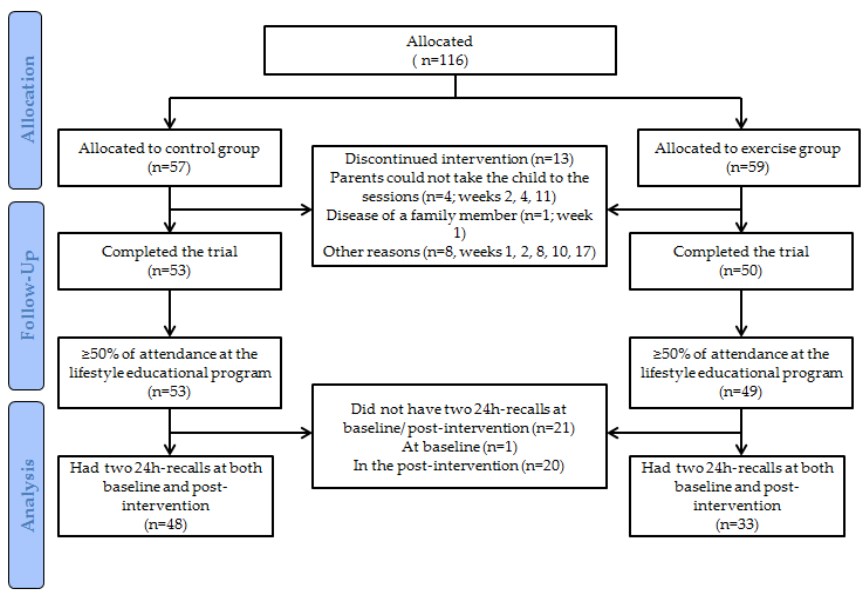
Figure 1. Flowchart of children participating in the study.